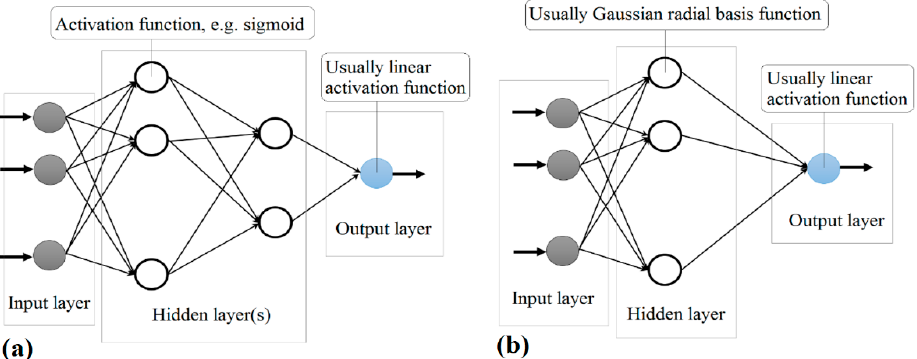
Figure 1. The general structure of ( a ) multilayer perceptron and ( b ) radial basis function neural network.